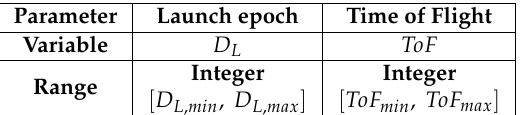
Figure 6. The gene map of the heliocentric cruise design problem describing the different design variables and their